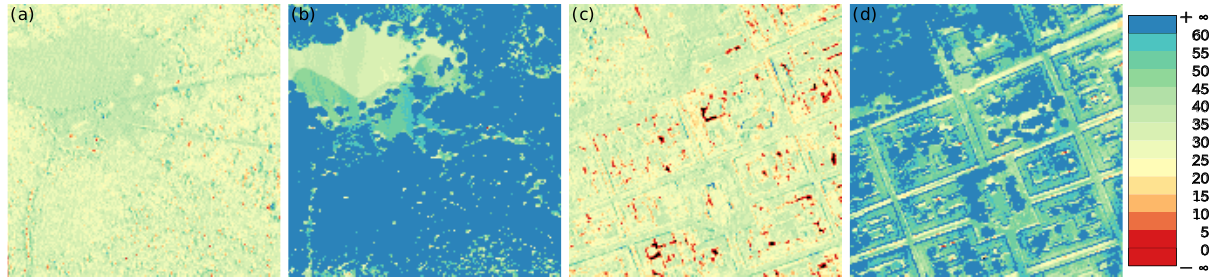
Figure 6. 3D point cloud of forest test area; (a) SPL, (b) Waveform LiDAR, (c) longitudinal section: SPL unfiltered/postprocessed (red/green), waveform LiDAR (blue)